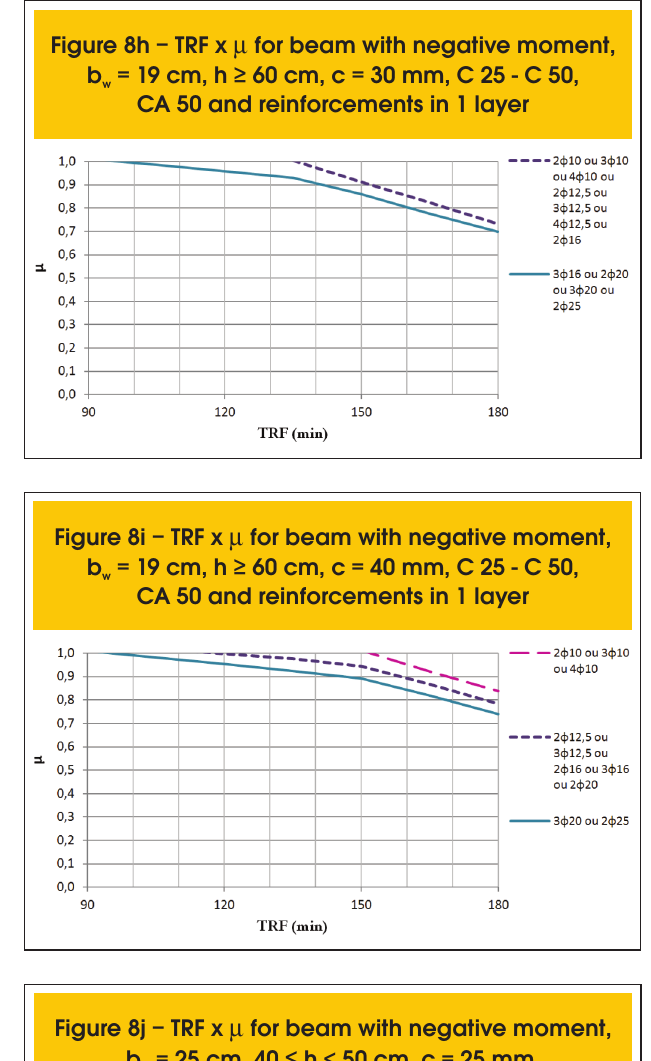
Figure 8g – TRF x m for beam with negative moment, b = 19 cm, h ≥ 60 cm, c = 25 mm, C 25 - C 50, w